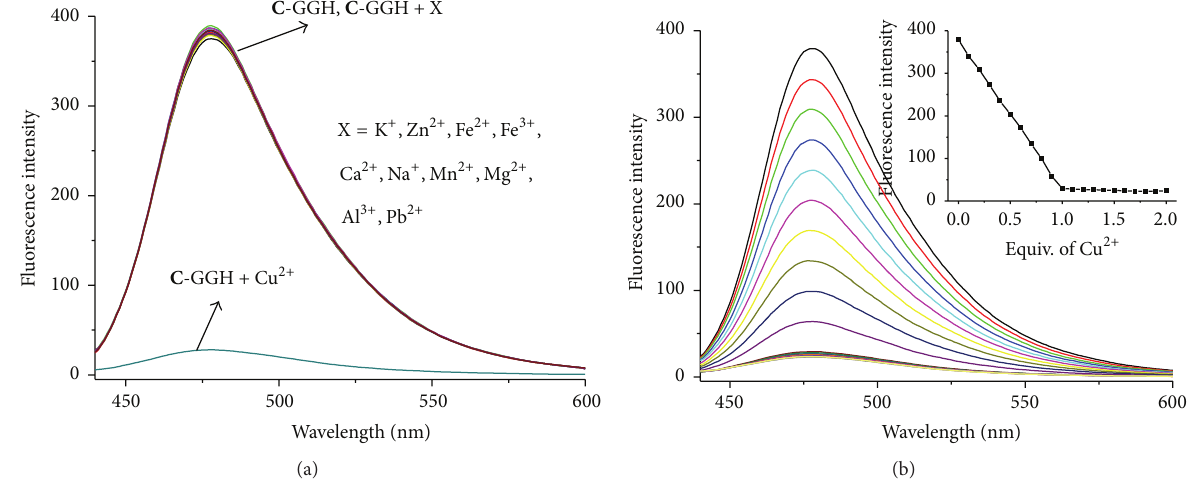
Figure 2: (a) Fluorescence responses of C -GGH (1 𝜇 mol/L) to different ions (2equiv. for K + , Zn 2+ , Fe 2+ , Fe 3+ , Ca 2+ , Na + , Mn 2+ , Mg 2+ , Al 3+ , and Pb 2+ ; 1 equiv for Cu 2+ ) in HEPES buffer aqueous solution (10mmol/L, pH 10.0). Fluorescence titration of C -GGH (1 𝜇 mol/L) with Cu 2+ (0–2 equiv.) in HEPES aqueous buffer (10mmol/L, pH 10.0). Inset shows fluorescence changes of C -GGH at 478 nm as a function of the Cu 2+ concentration.